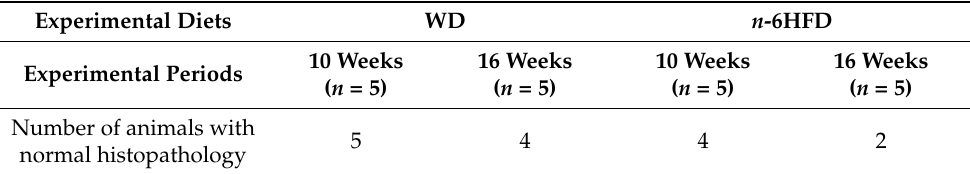
Table 1. Observed Colonic Inflammatory Events.